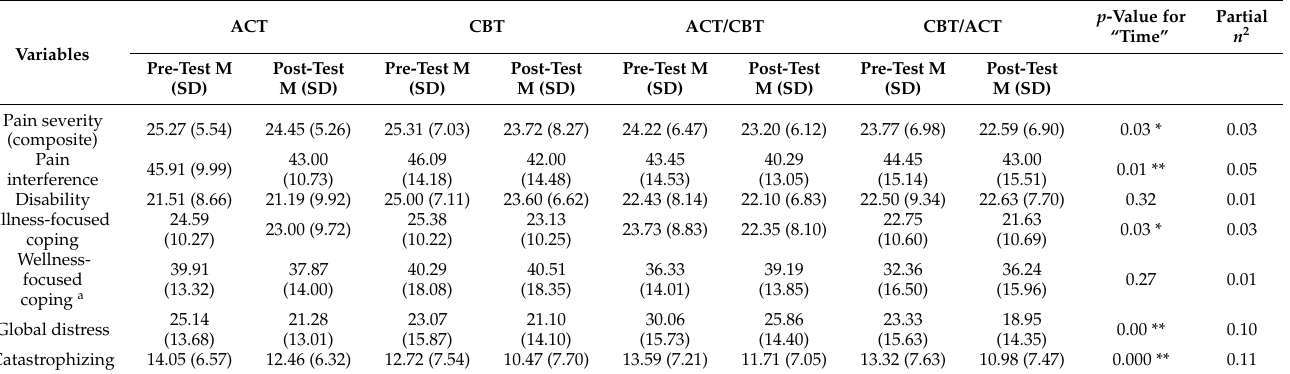
Table 2. Changes in outcome measures by